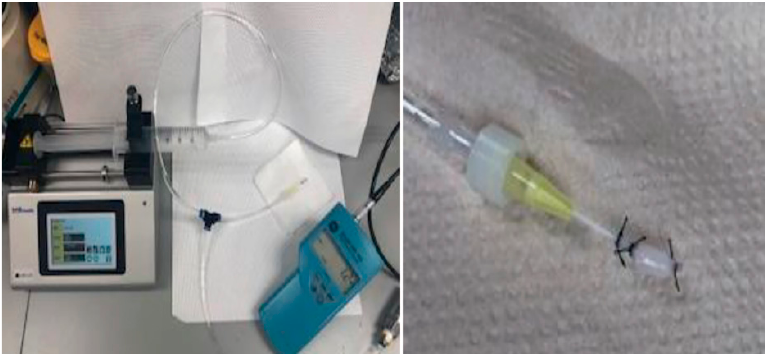
Figure 1. Video clips of sealing of the peritoneum, vessel, and ureter.